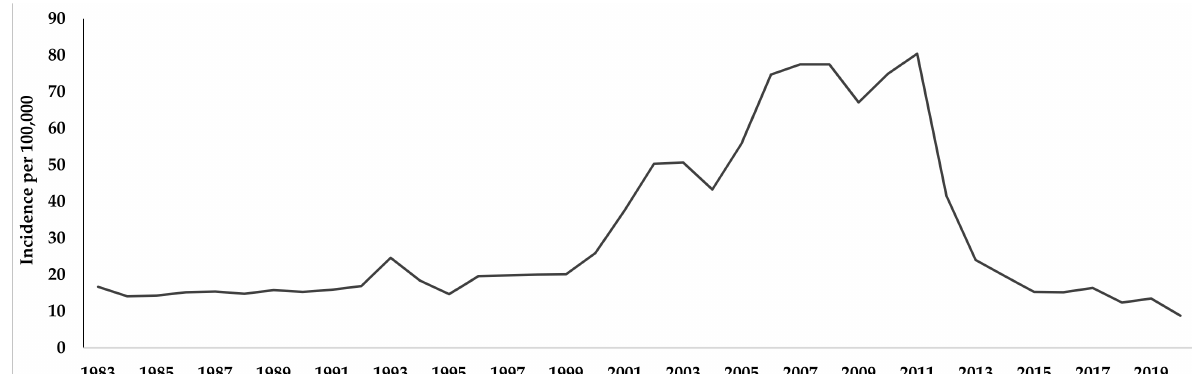
Figure 7. Incidence of human brucellosis in Kyrgyzstan from 1983 to 2019. Humans were tested positive in two consecutive Huddleson plate agglutination test and Wright tests, based on data from